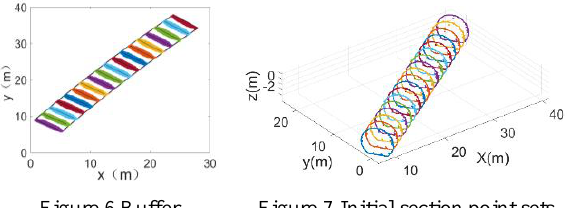
Figure 6 Buffer Figure 7 Initial section point sets